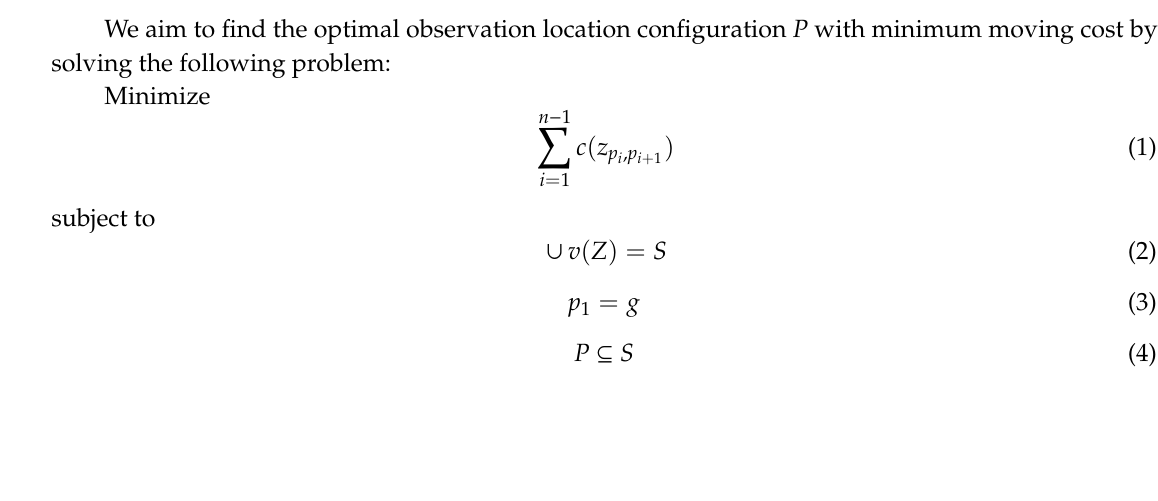
Figure 2. ( a ) Test map; ( b ) optimal path P (